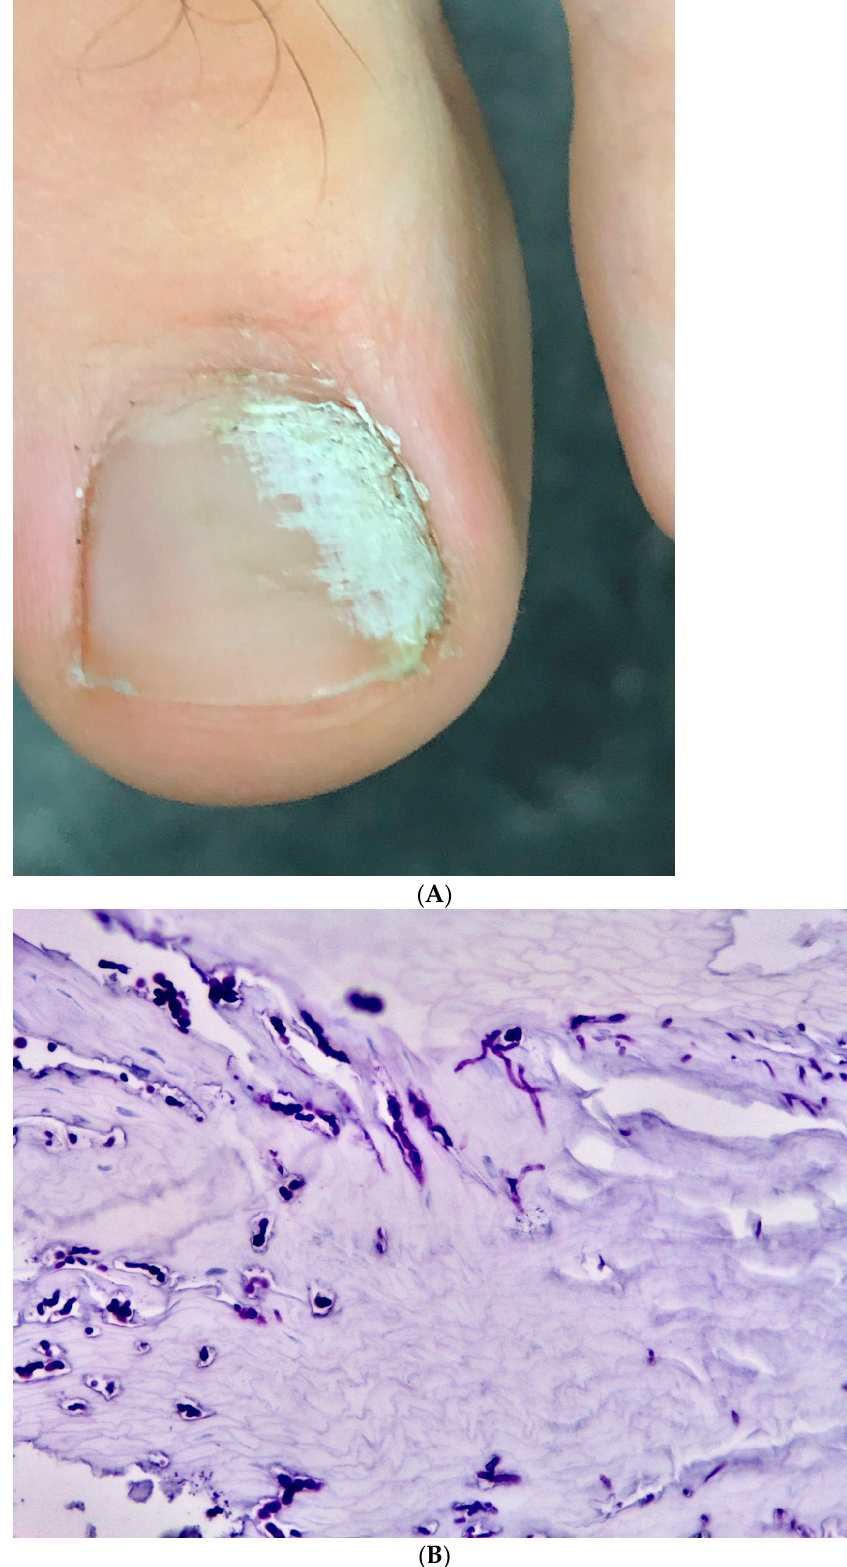
Figure 8. Post-traumatic single-digit onychomycosis of the big toe due to Fusarium solani . ( A ) Clinical picture, ( B ) histopathology of the nail clipping showing fungal filaments of variable diameter and spore-like elements; PAS, original magnification 200×.